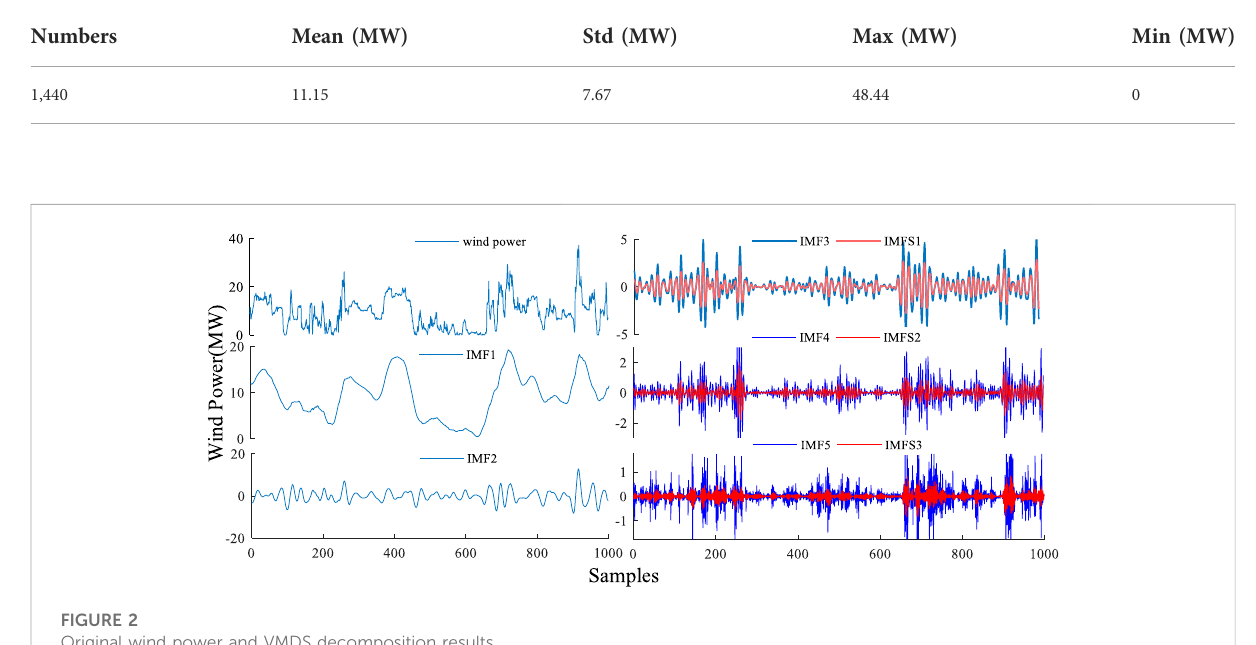
FIGURE 2 Original wind power and VMDS decomposition results.